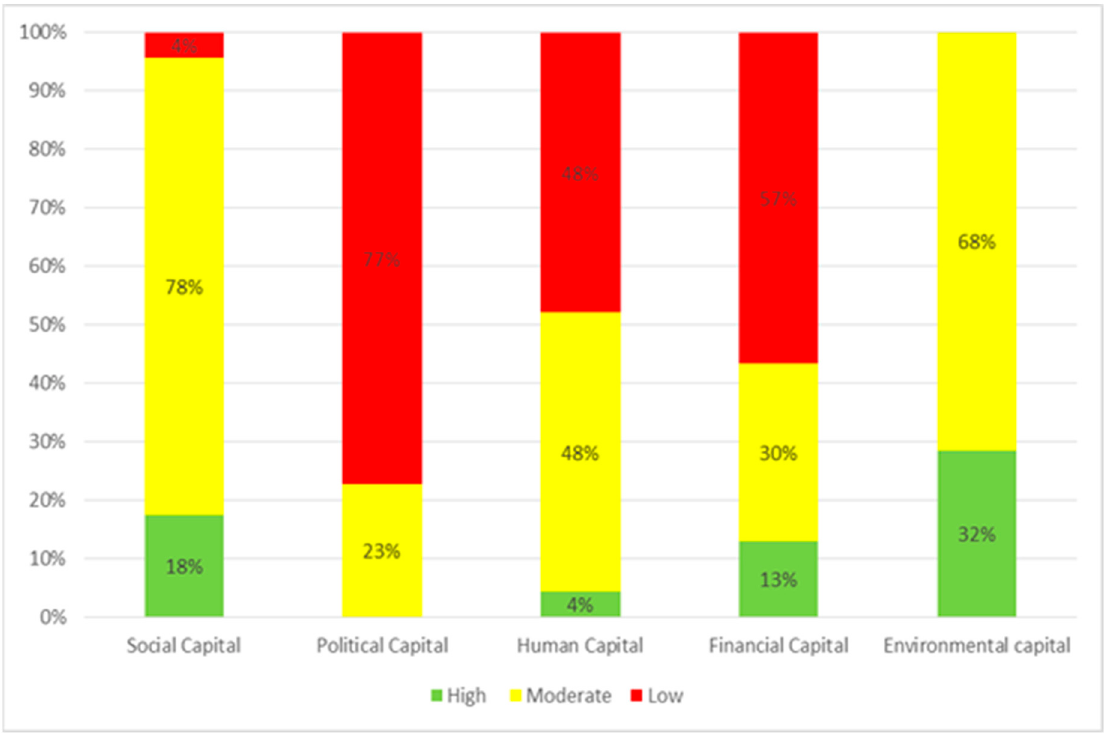
Figure 5. Assessment of the capacity of local government to implement climate change adaptation policies in Seychelles.